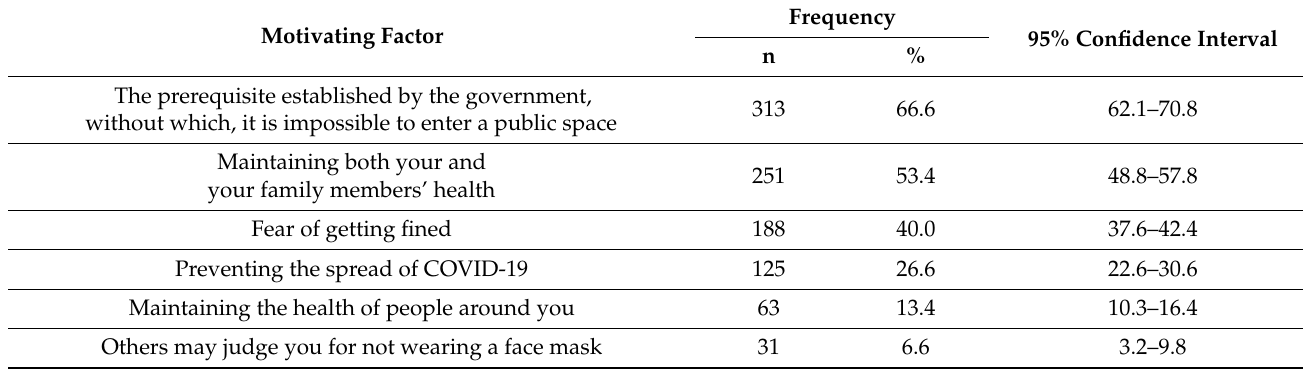
Table 4. Motivating factors for public transport passengers to wear a face mask.